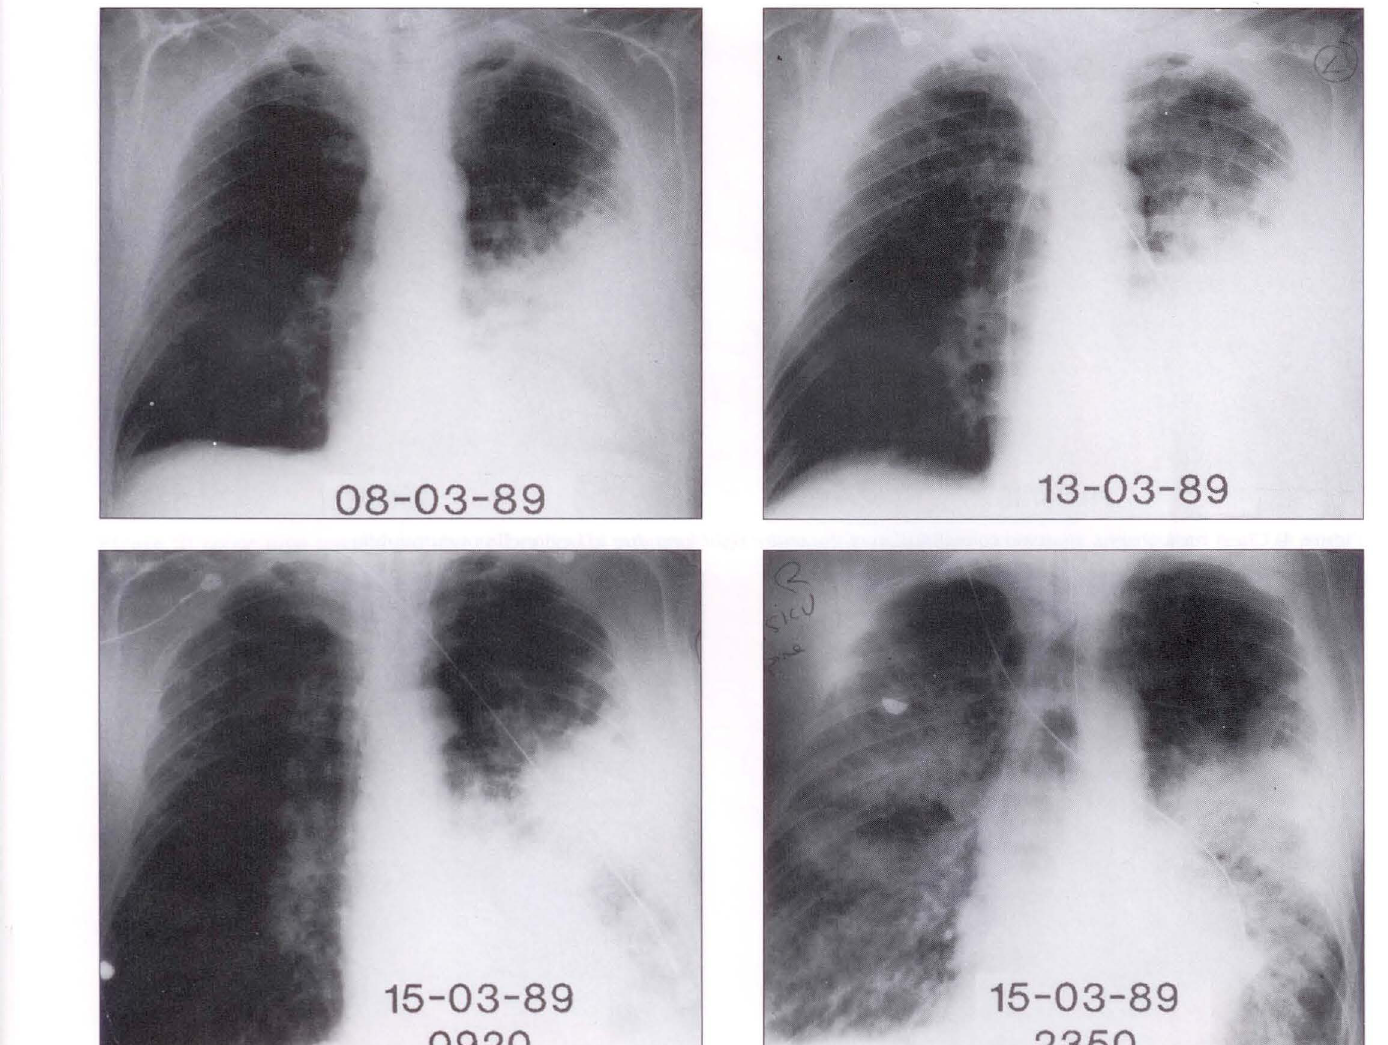
Figure 6) Serial chest radiographs of a 69-year-old male admitted Pebmary 21. 1989 with an exacerbation of chronic lung disease. The chronology of his course in hospital is shown in Figure